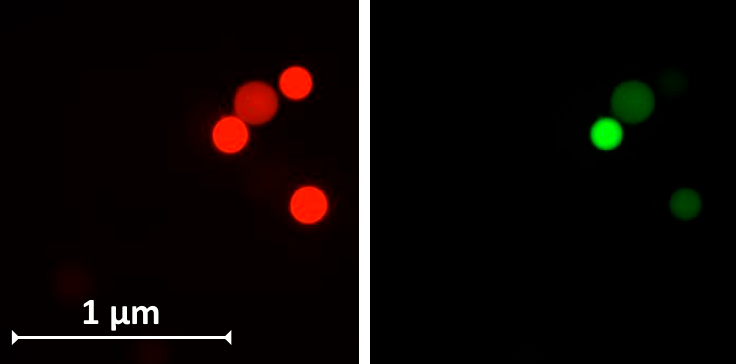
1 μm Figure A1. Representative fluorescence microscope images of library beads binding red- and green- labeled affibodies at different binding ratios.